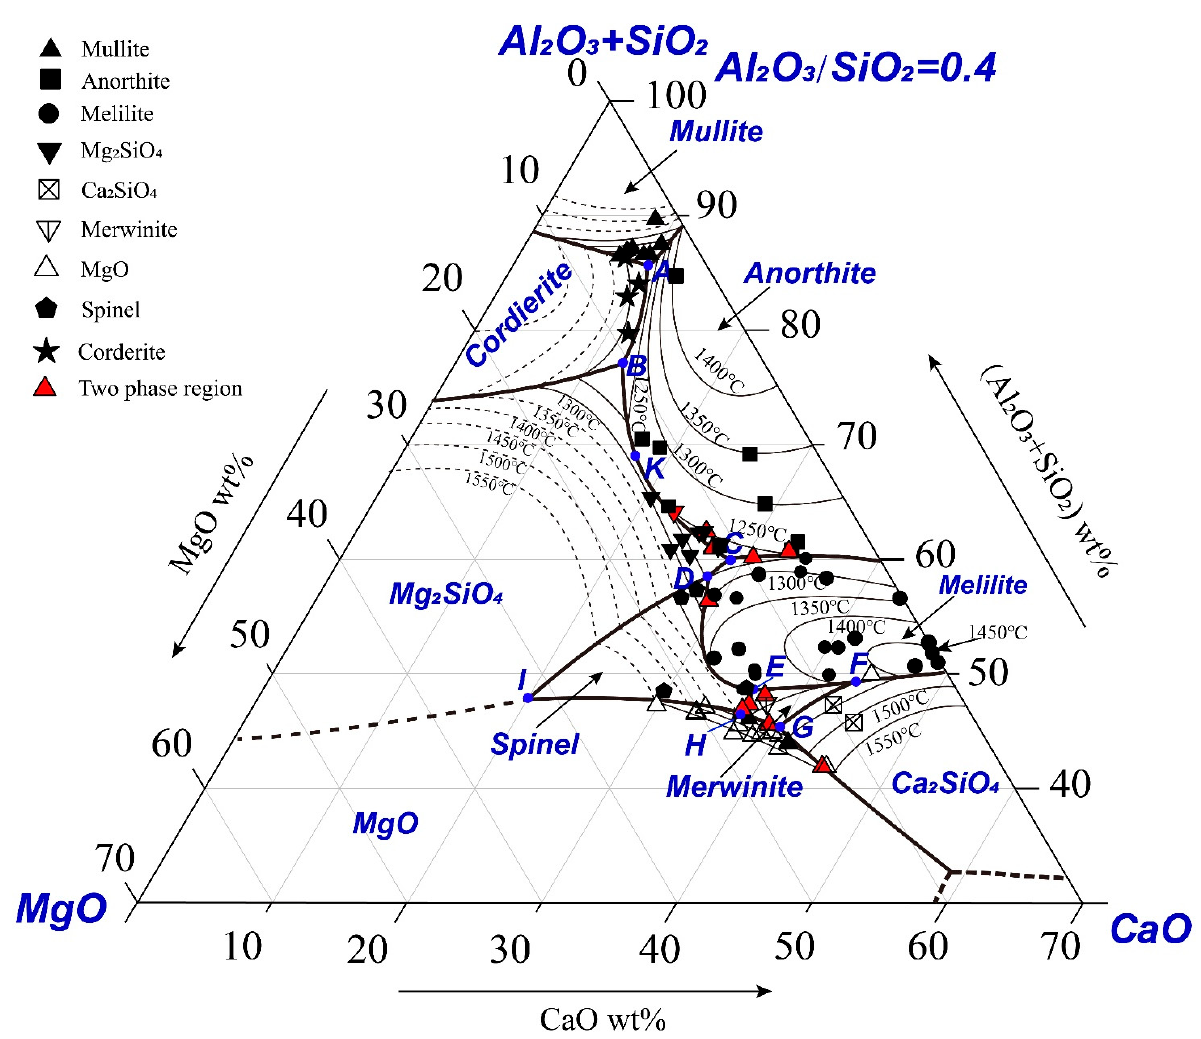
Figure 3. Experimentally determined pseudo-ternary phase diagram (SiO 2 +Al 2 O 3 )-MgO-CaO with Al 2 O 3 /SiO 2 weight ratio of 0.4.